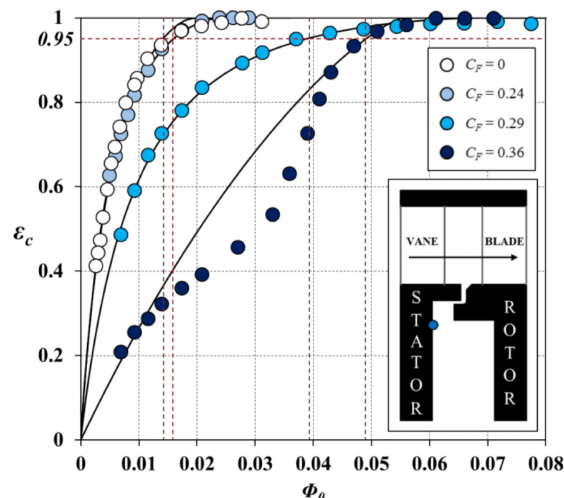
Figure 10. Effect of flow coefficient C F on the variation of ε c with Φ 0 for the single radial-clearance seal in the upstream wheel-space (symbols denote data; black lines are theoretical curves; red dashed lines indicate the values of Φ min (cid:48) ) ( Re ϕ = 7.2 × 10 5 , r / b =